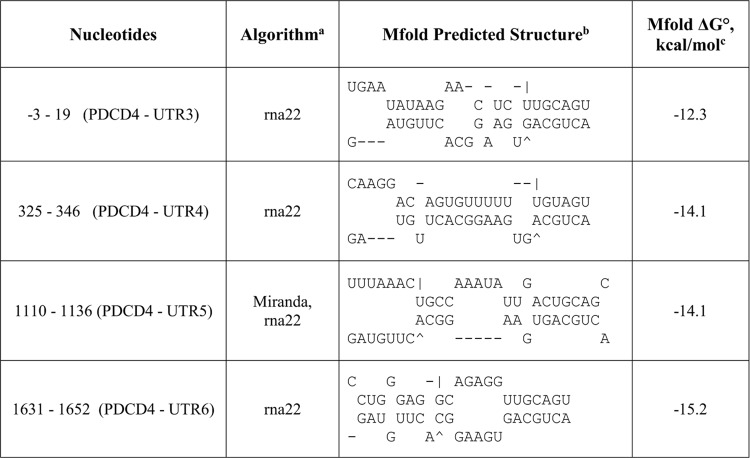
Predicted miR-17-3p passenger strand binding sites in the 3'UTR of PDCD4 mRNA.
aThe potential oncomiR:mRNA binding sites were identified by rna22, Targetscan, or miRanda. bTop strand is mRNA (5' ➔ 3') and the bottom strand is oncomiR (3' ➔ 5'). cCalculated at http://mfold.rna.albany.edu/?q=mfold.